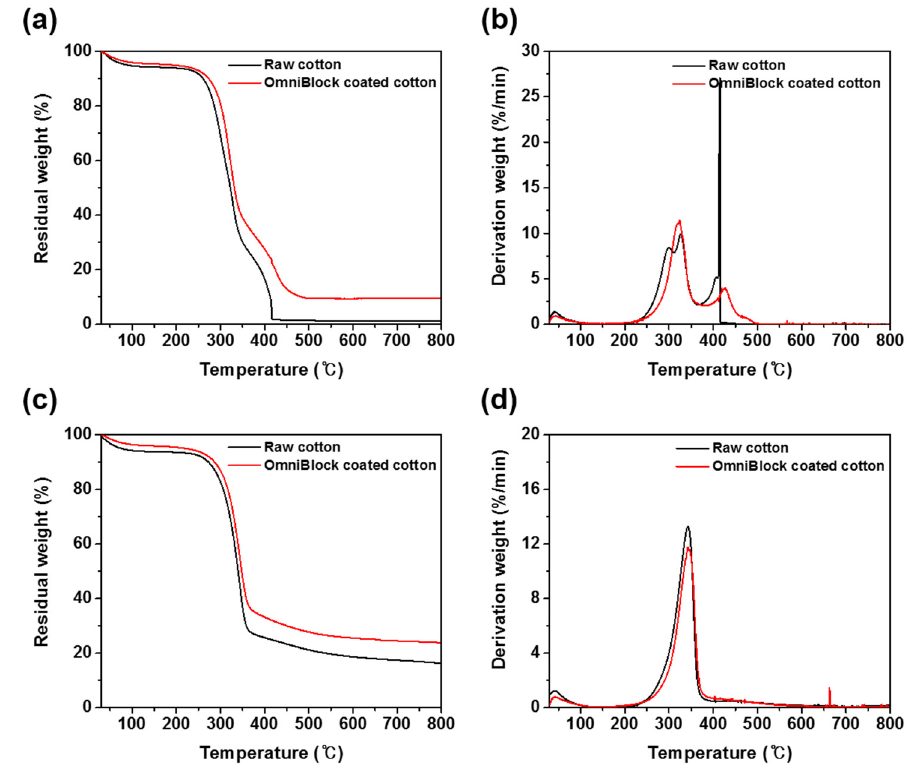
Figure 4. TGA and DTG curves of raw and OmniBlock-coated cotton fabrics ( a , b ) in air and ( c , d ) nitrogen.